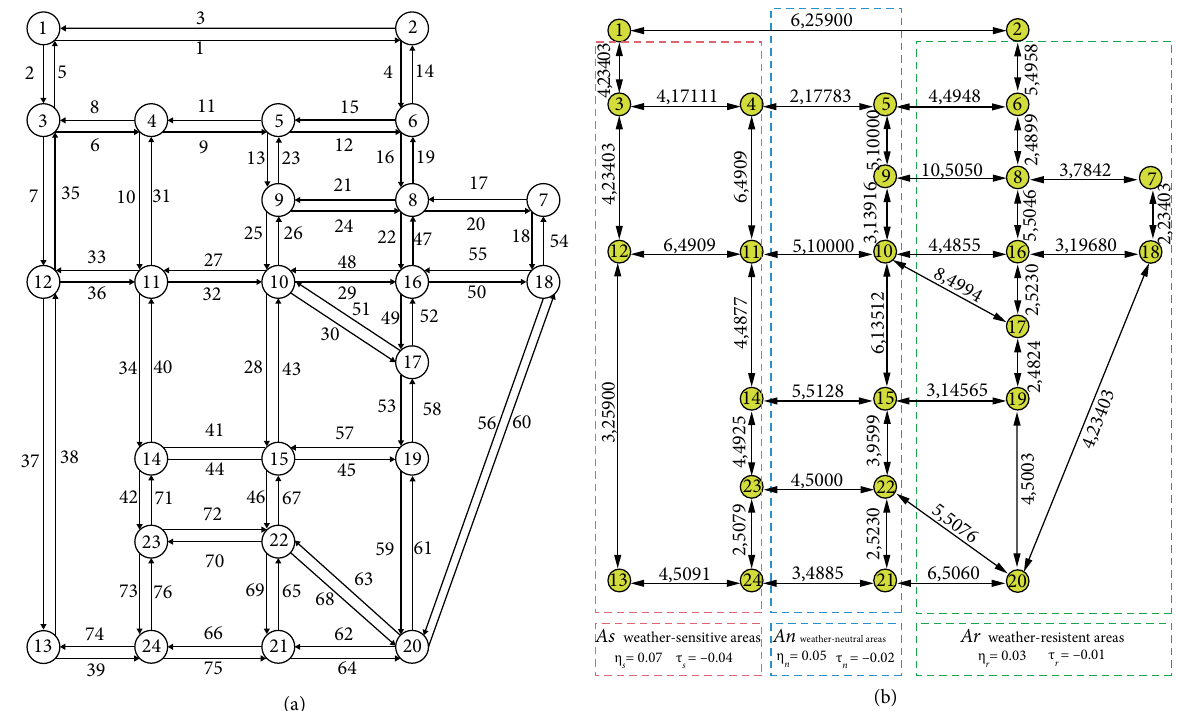
Figure 8: Sioux Falls network. (a) Numbers of nodes and links. (b) Link free flow travel time and ideal link capacity.